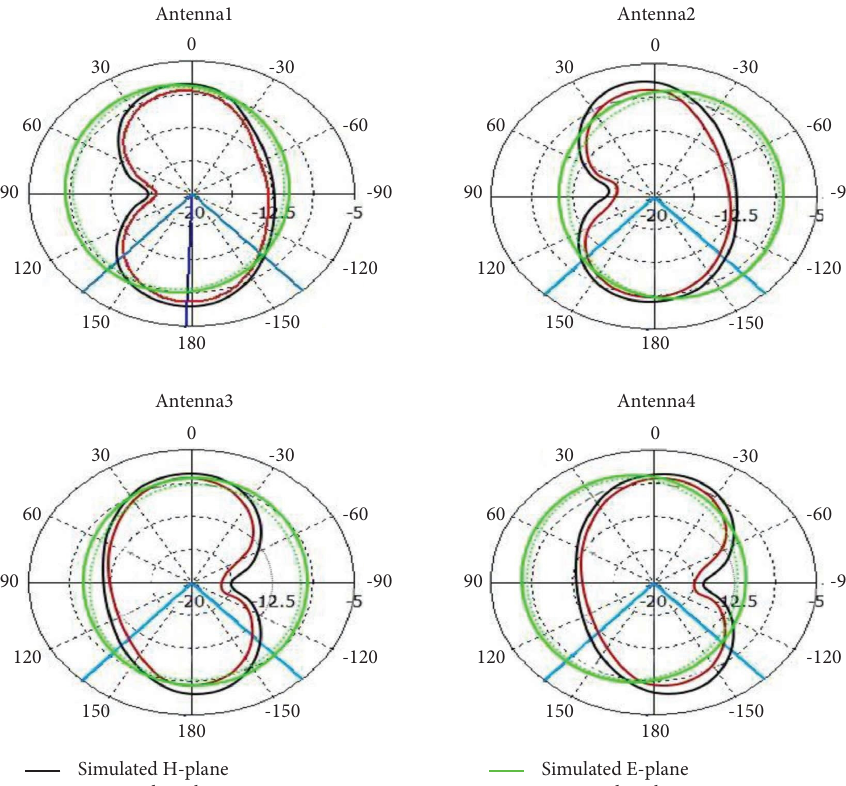
Figure 17: Simulated and measured radiation patterns in E plane and H plane.